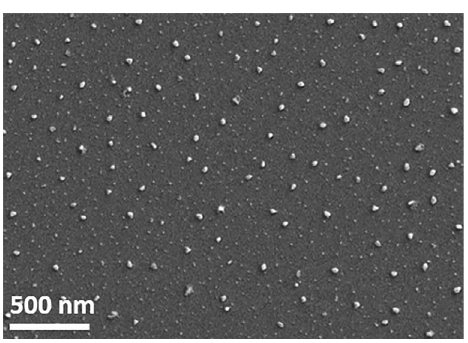
FIGURE 3 - Electrochemical impedance spectroscopy (EIS) of bare glassy carbon electrode (GCE), C-ZnO/GCE and B-ZnO/